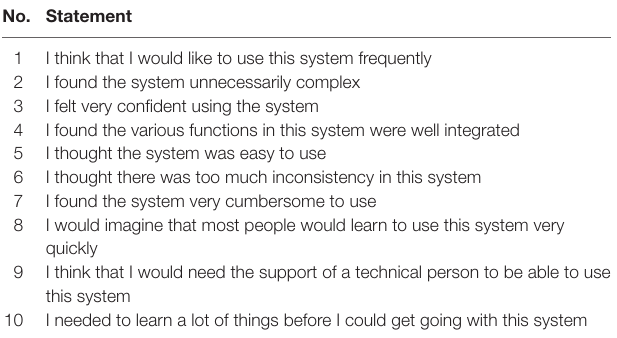
TaBle 1 | statements of system Usability scale (sUs) questionnaire.